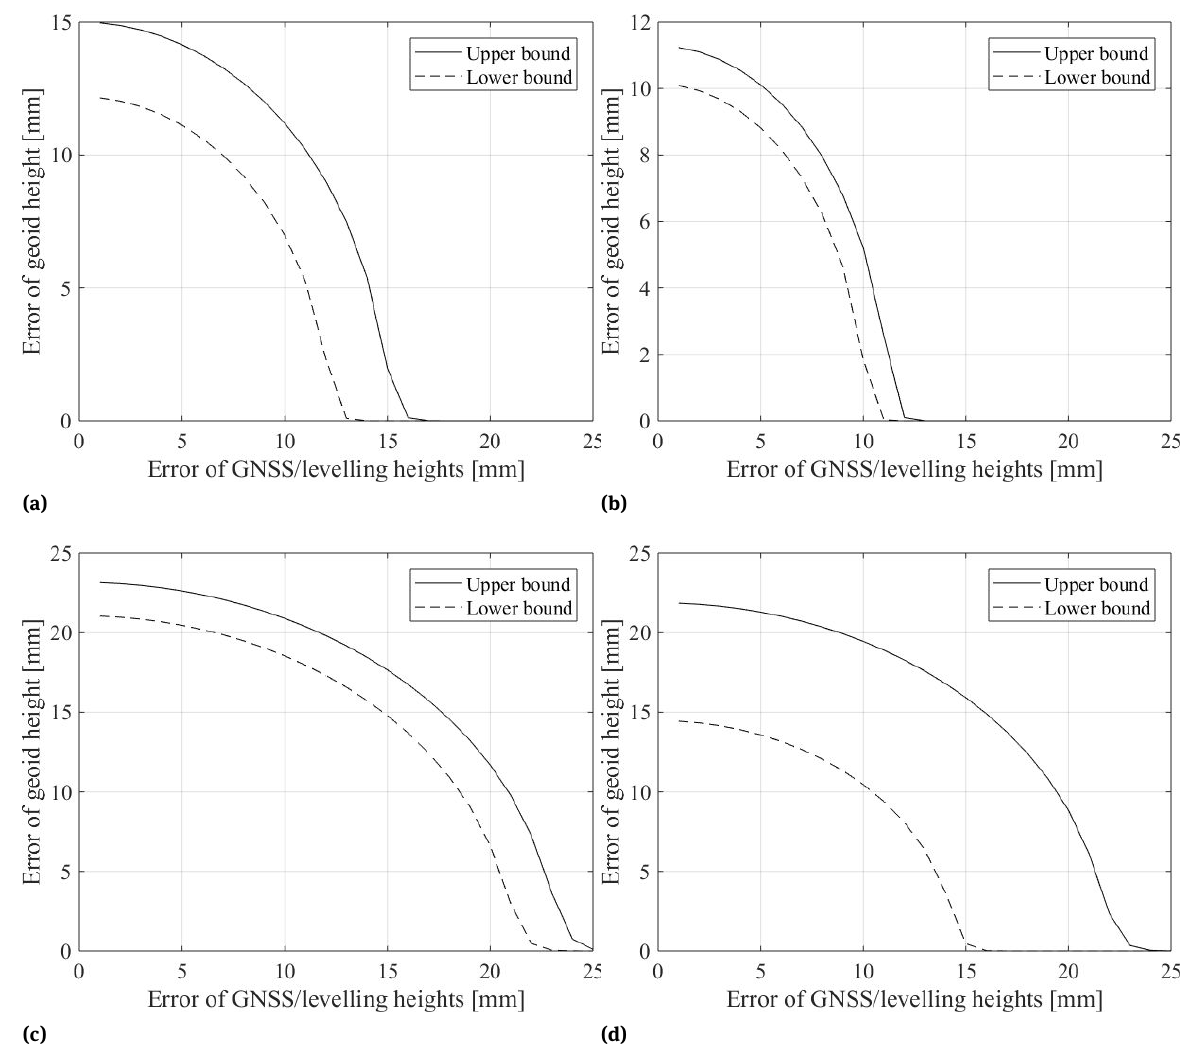
Fig. 4. The graphical relation between the CIs of the error of the NKG2015 geoid model, based on different values of error for the GL heights in a) Sweden, b) Denmark, c) Norway and d)